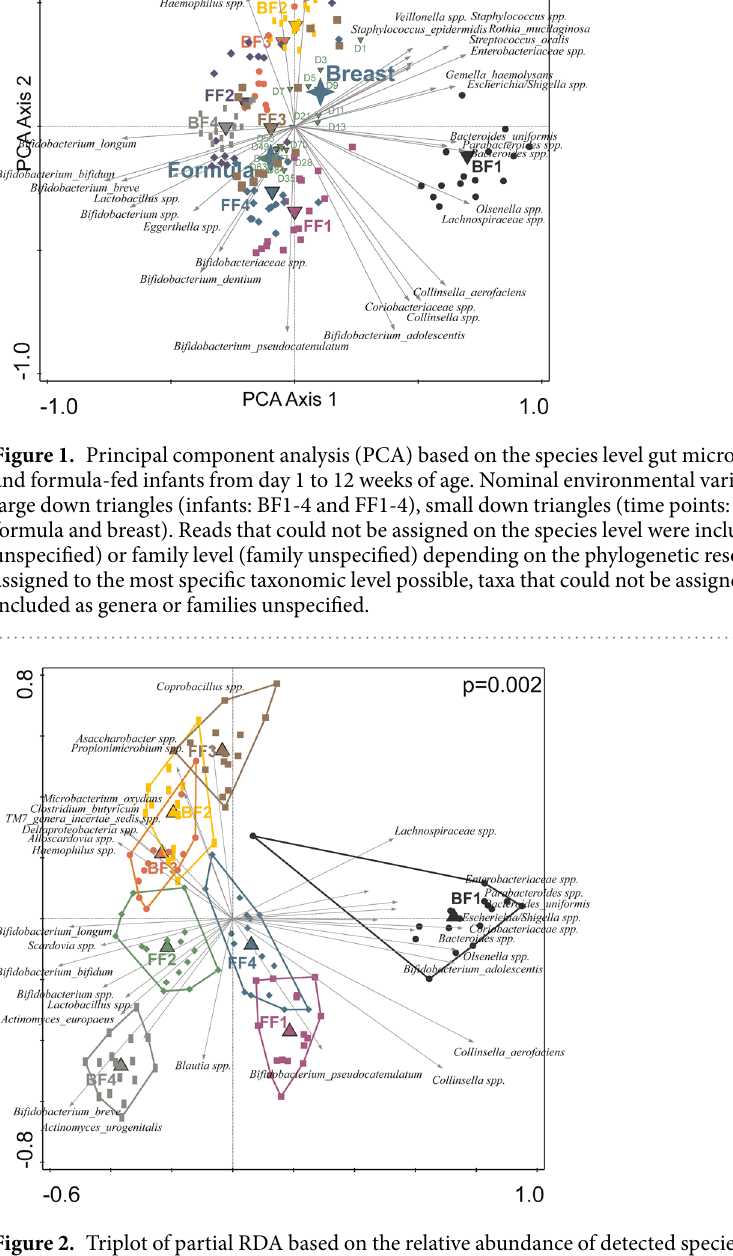
finding that microbiome development of the breastfed infants is more individually determined (explained varia- tion is 7.0%, P = 0.02, see also Fig. 4B,C). Classification of the 16S sequences down to the species level revealed the presence of the potential gastroin- testinal tract pathogens C. perfringens and C. difficile , but also the upper oro-gastrointestinal and respiratory tract